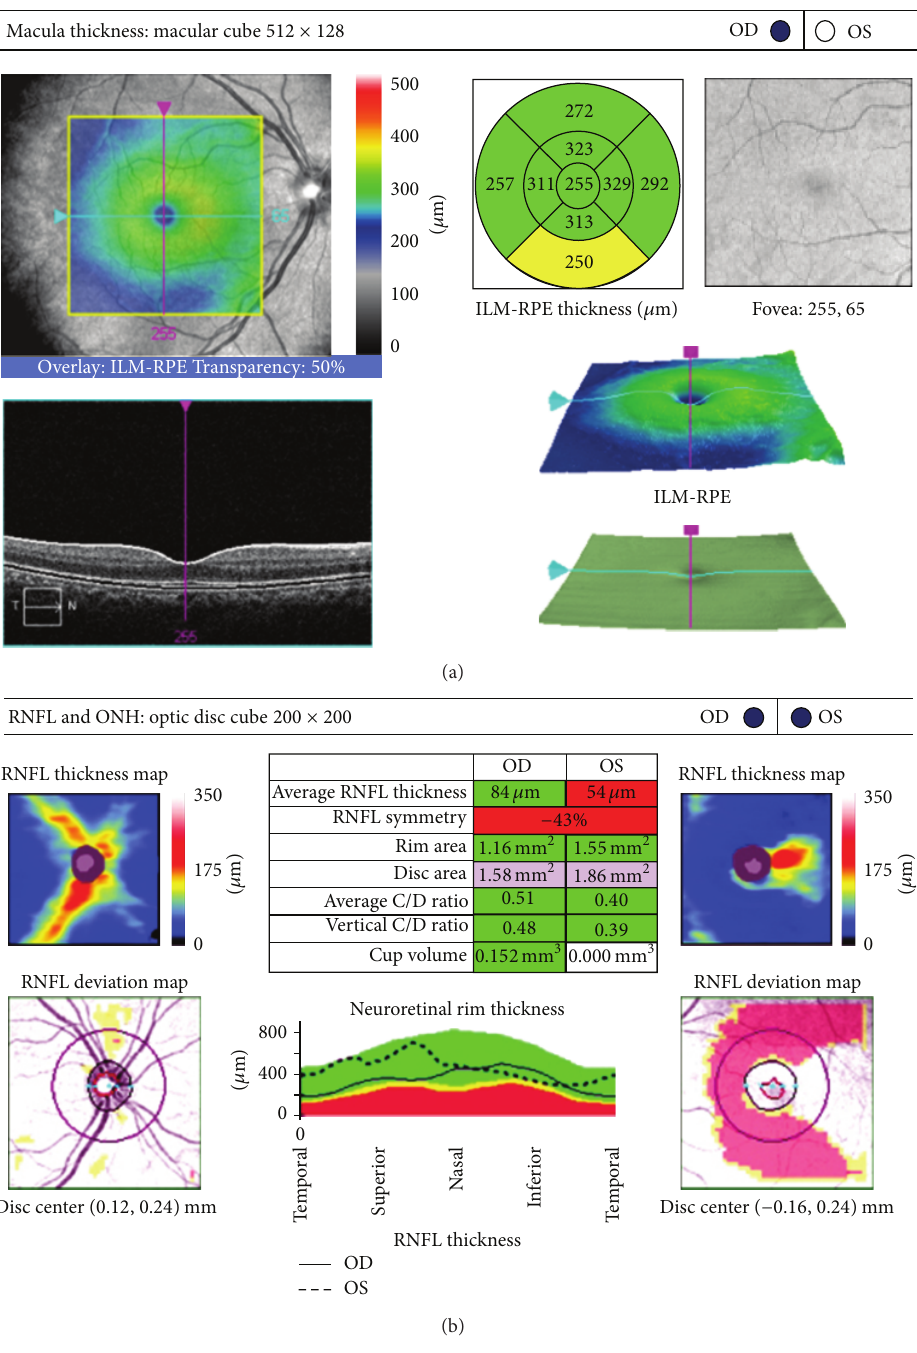
Figure 1: (a) “Macular Cube 512 × 128” software, measuring total macular thickness, producing a map with 09 subfields of sectoral thicknesses in three concentric circles, as defined by ETDRS. (b) “Optic Disc Cube 200 × 200” software for measuring the RNFL around the optic nerve, producing a map with 04 areas and optic disc parameters. The same software was used in the macular region to measure the thickness of the nerve fiber layer of the